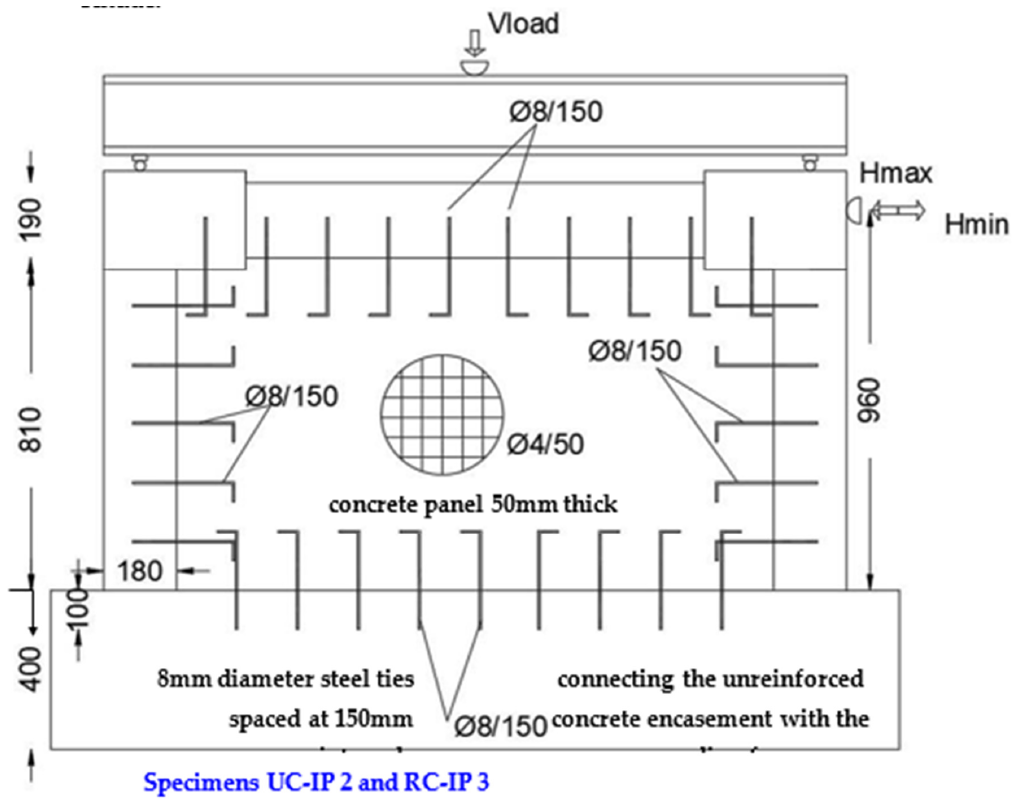
Figure 11. Specimens UC ‐ IP 2 and RC ‐ IP 3.